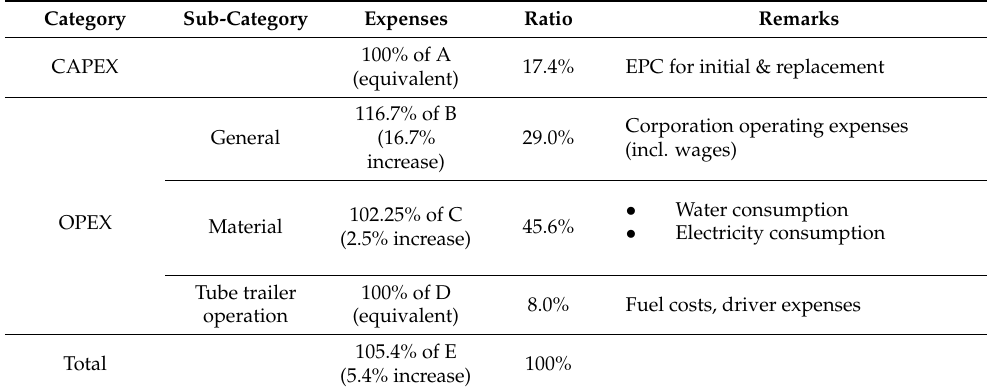
Table 18. Estimation of whole expenses and breakdown (Scenario